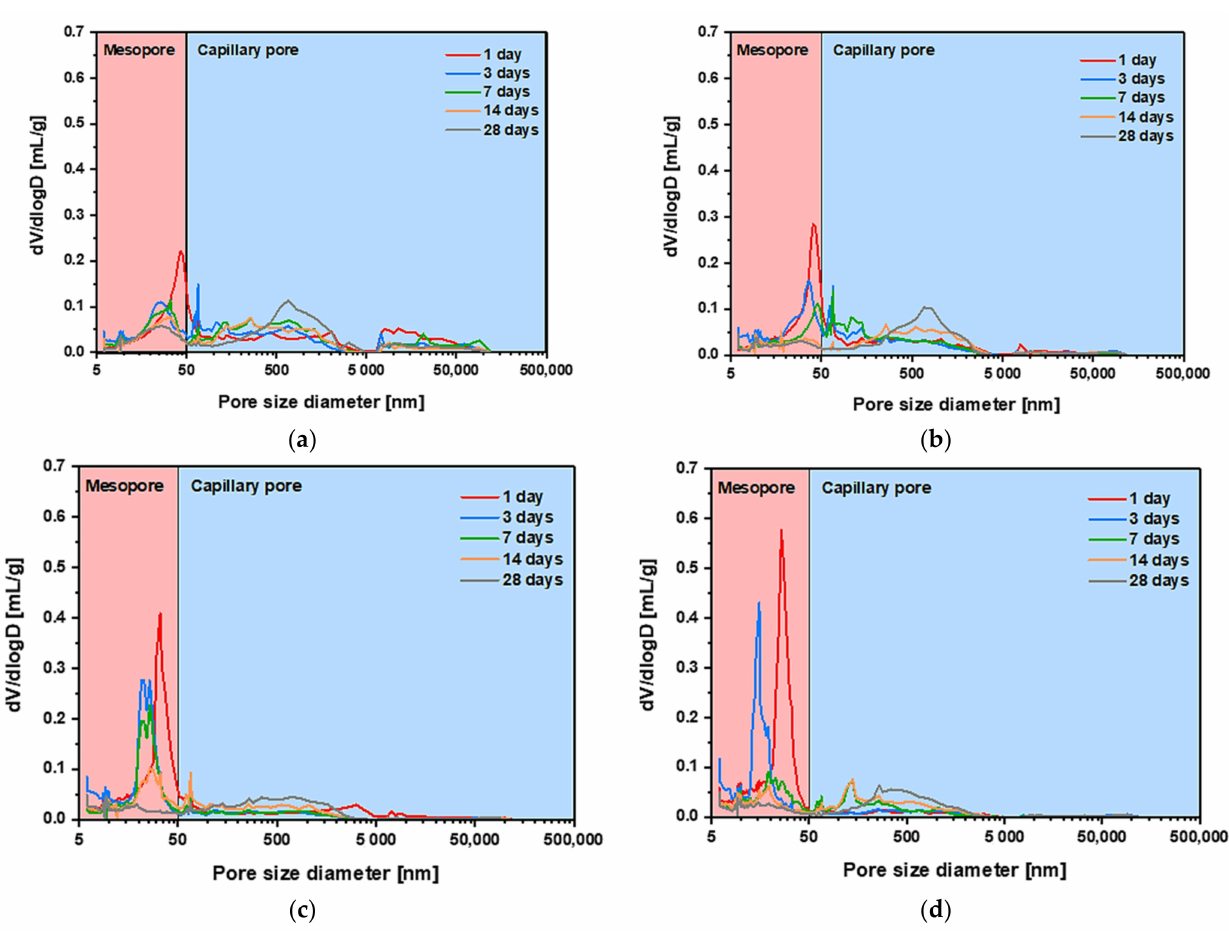
Figure 6. Pore-size distribution of cement mortar blended with SF: ( a ) S00 specimen; ( b ) S10 specimen; ( c ) S20 specimen; ( d ) S30